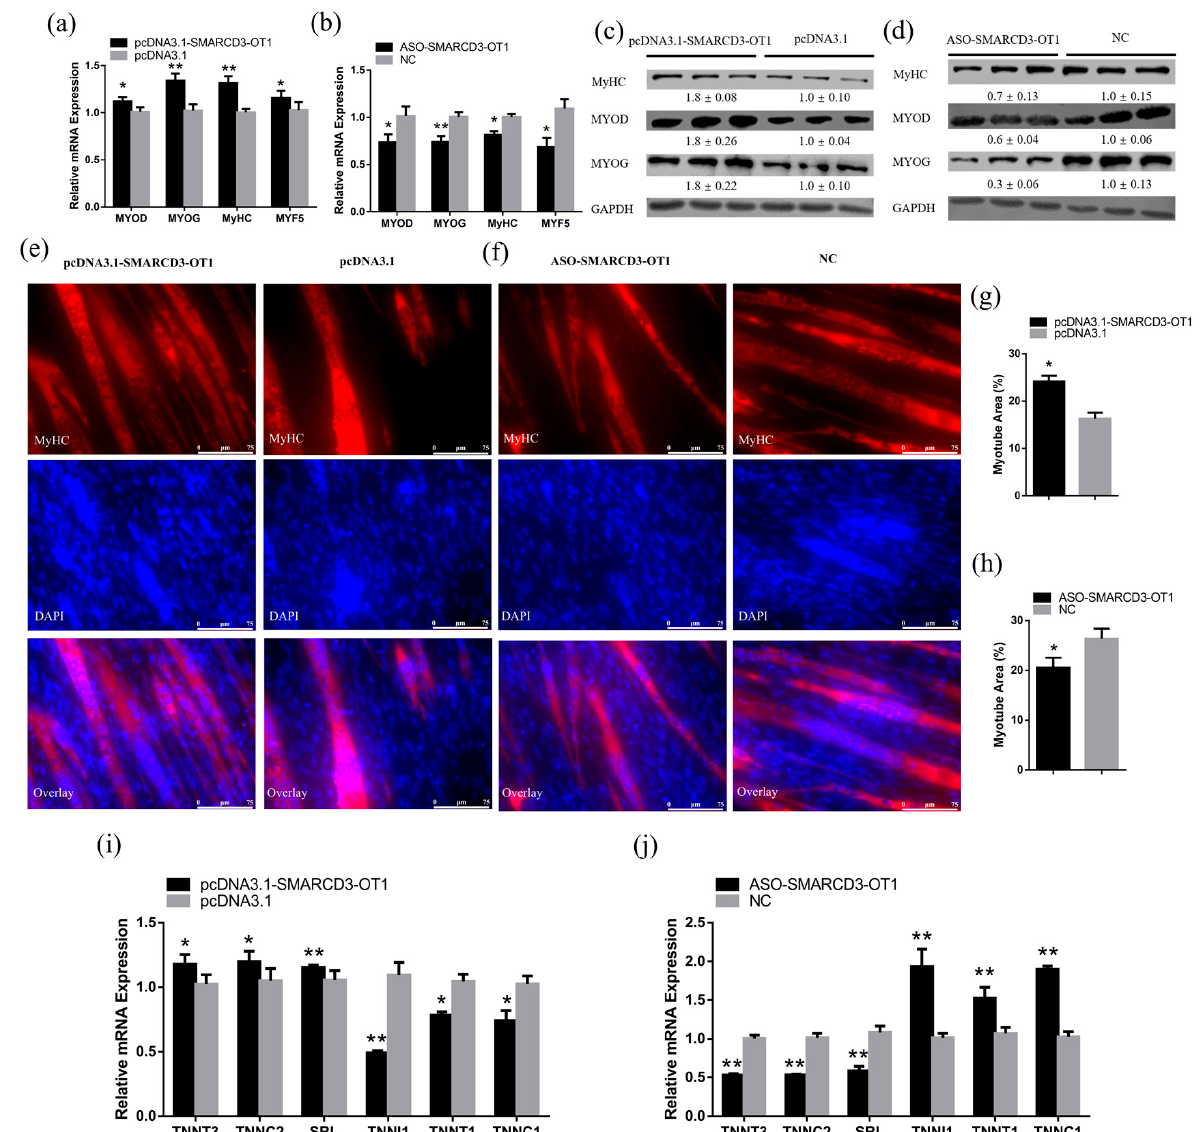
Figure 3. SMARCD3-OT1 promotes the differentiation of myoblasts during the differentiation stage, facilitating myofiber transformation. ( a , b ) Relative mRNA levels of several cell differentiation marker genes after overexpression or knockdown of SMARCD3-OT1 ( n = 6). ( c , d ) Relative protein levels of several cell differentiation marker genes after overexpression or knockdown of SMARCD3-OT1 ( n = 3). The numbers shown below the bands were folds of band intensities relative to control. Band intensities were quantified by ImageJ and were normalized to GAPDH. ( e , f ) MyHC immunostaining of CPMs transduced with SMARCD3-OT1 overexpression or knockdown. Cells were differentiated for 72 h after transfection. The nuclei were visualized with 4 (cid:48) ,6-diamidino-2-phenylindole buffer (DAPI) ( n = 6). ( g , h ) Myotube area (%) of CPMs transduced with SMARCD3-OT1 overexpression or knockdown in immunofluorescence assay ( n = 6). ( i , j ) Relative mRNA levels of several fast-twitch fiber- and slow-twitch fiber-related genes after overexpression or knockdown of SMARCD3-OT1 ( n = 6). All differentiation-related experiments are performed in CPMs after 3 days of differentiation induction using the differentiated medium. Data are expressed as a fold change relative to the control. Results are shown as mean ± SEM. Statistical significances of differences between means were assessed using an independent sample t test. * p < 0.05, ** p <